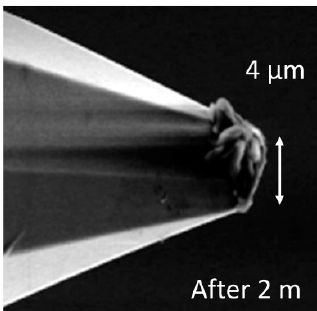
Figure 18. SEM image of a microprobe tip after measurements at a length of 2 meters on a roughness standard.